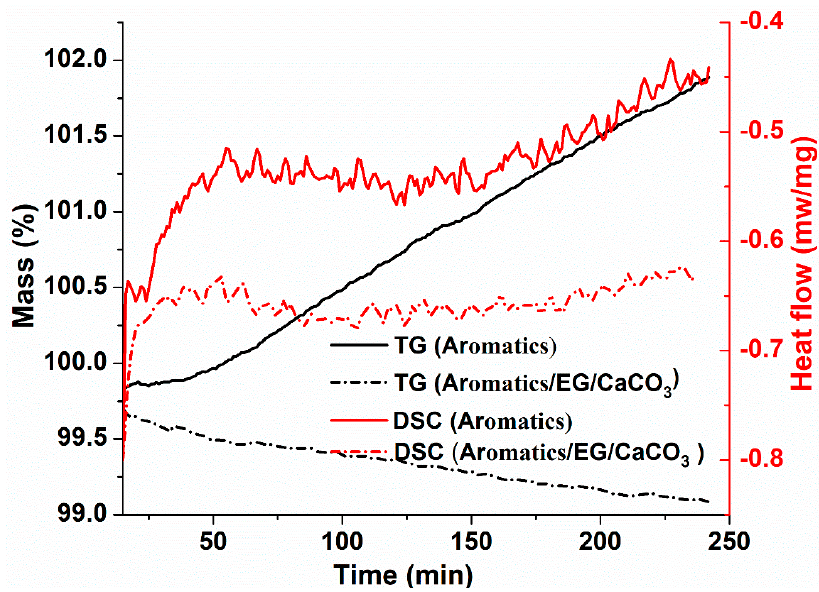
Figure 2. TG and DSC curves of aromatics and aromatics / EG / calcium carbonate (CaCO 3 ) during the isothermal-oxidative